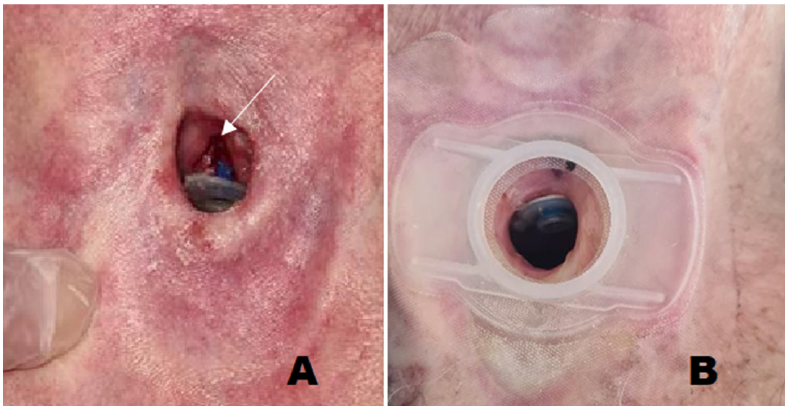
Figure 3. The figure illustrates an example of tracheoesophageal fistula with voice prosthesis managed with fat grafting. ( A ) The fistula is enlarged (arrow) causing leakage of saliva and food; ( B ) after fat grafting there is no leakage, as proved with a methylene blue dye